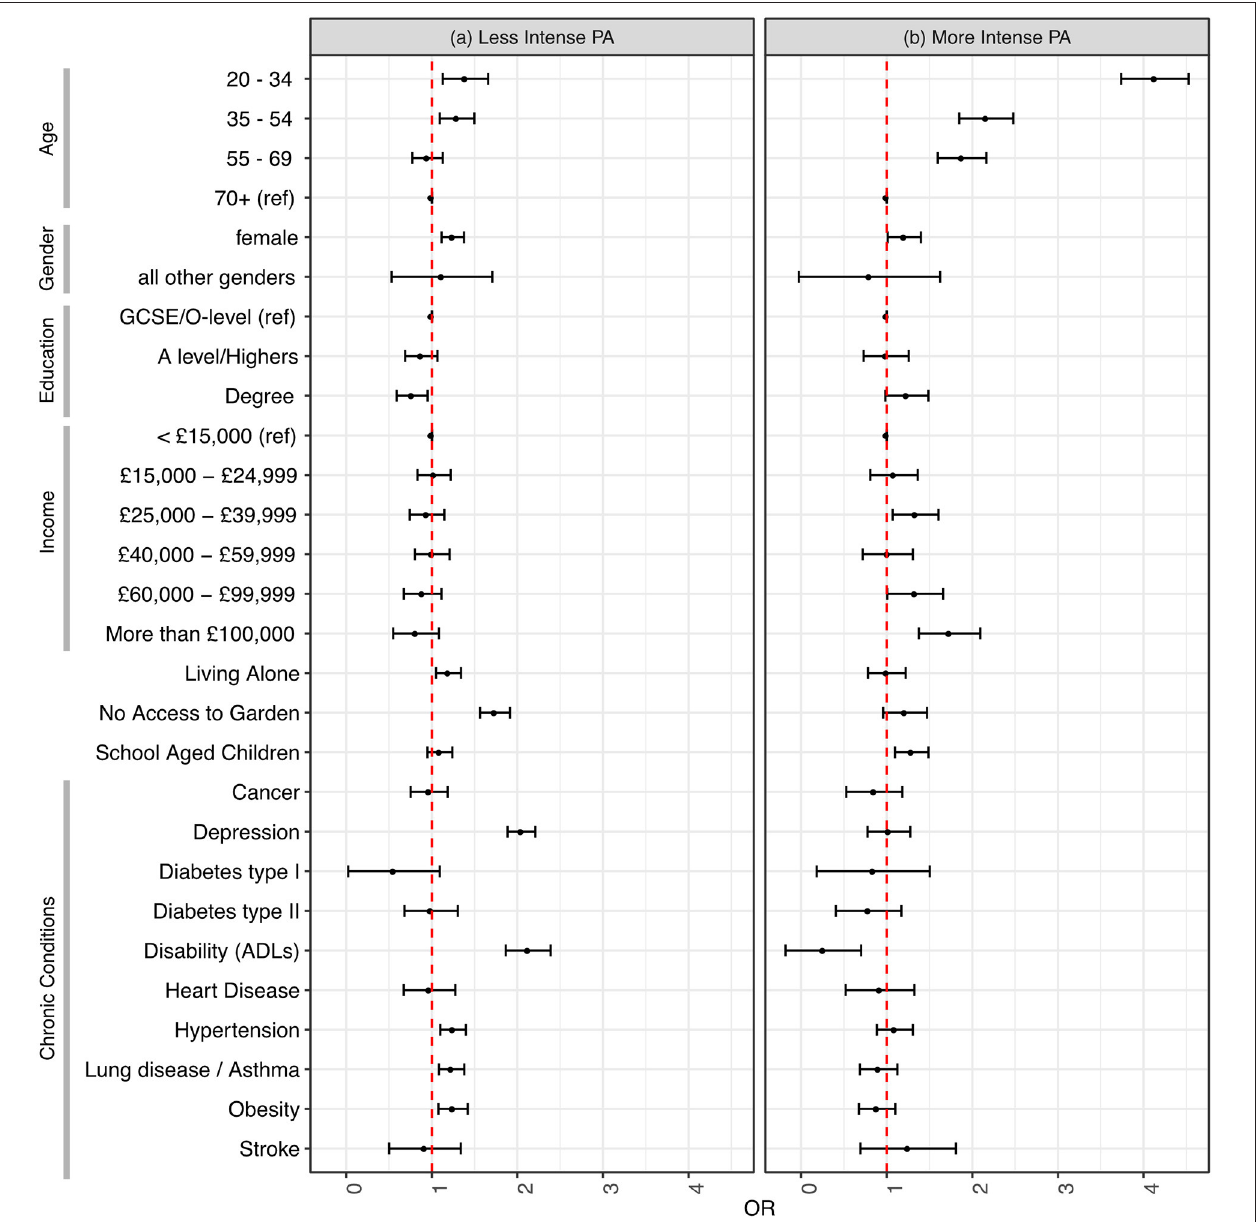
FIGURE 1 | Odds ratios for having changed toward (a) less intense and (b) more intense physical activity since the UK COVID-19 lockdown began. The reference group is study participants who continued to do the same intensity of physical activity. All odds ratios are corrected for baseline physical activity intensity and all other